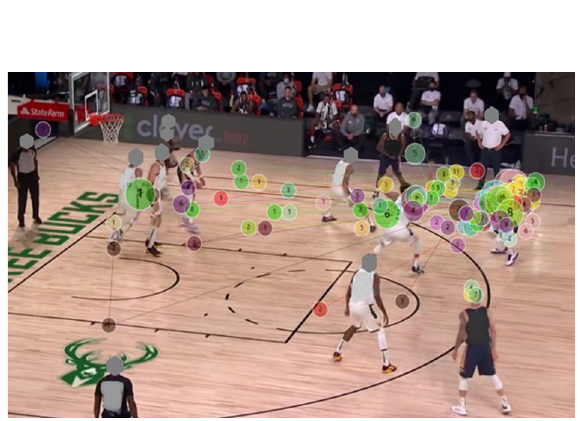
Figure 7. Aggregated Gaze Plot for